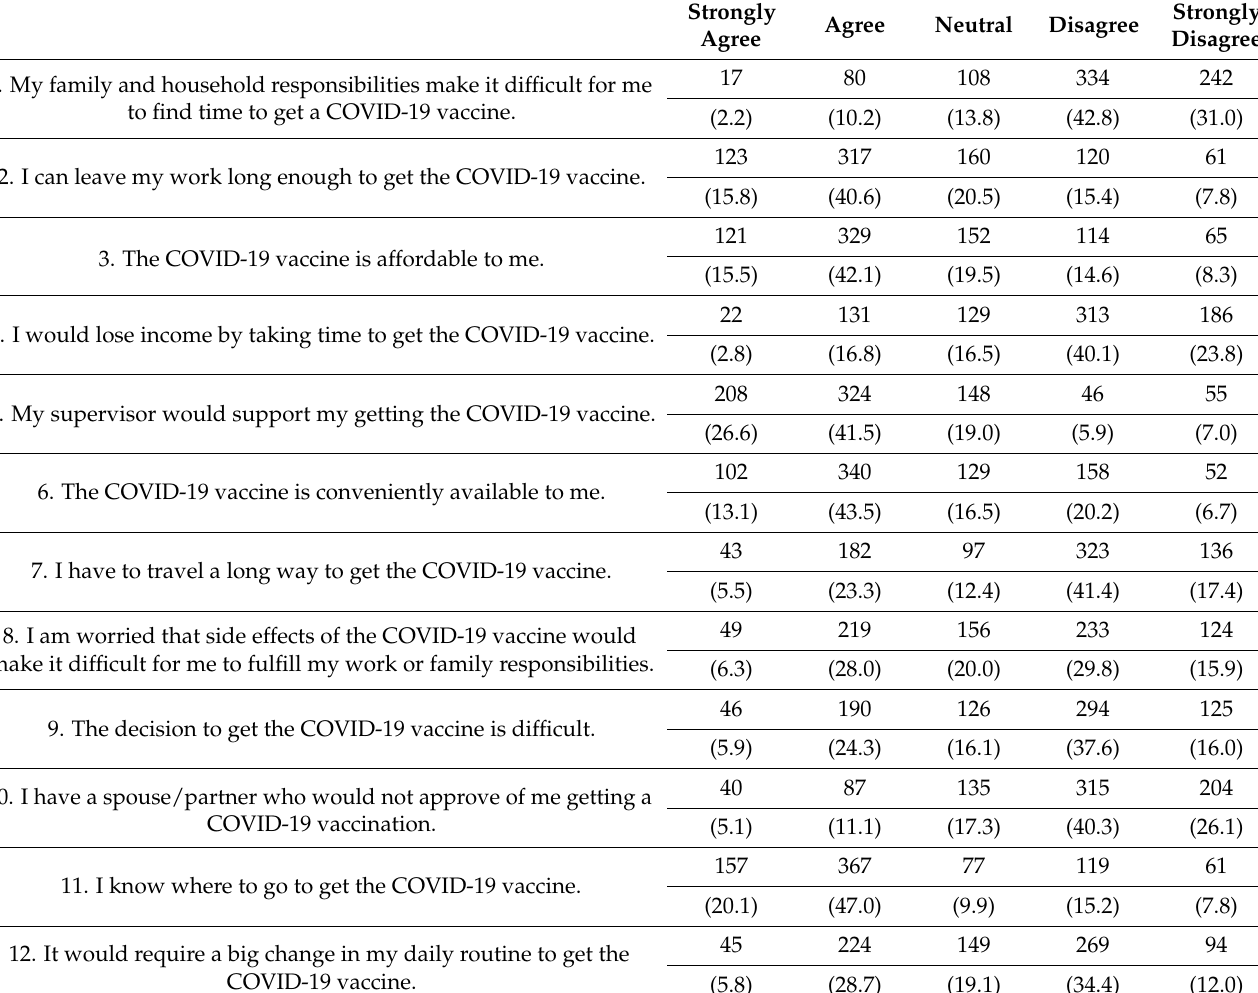
Table 2. Distribution of responses to ability index items ( n =